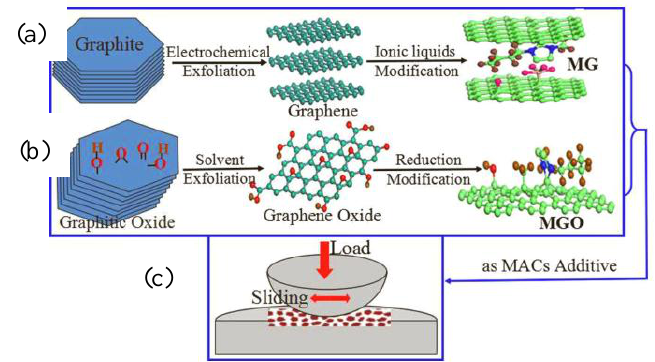
Figure 5. The preparation and tribological properties tests of modified graphene (MG) and modified graphene oxide (MGO). ( a , b ) Modified graphene (MG) and modified graphene oxide (MGO) were prepared using alkyl imidazolium ionic liquids by electrochemical exfoliation and solvent exfoliation, respectively. ( c ) Schematic of tribological properties tests of MGO and MG. Reproduced with permission from reference Fan et al. [92], Copyright 2015, Elsevior.